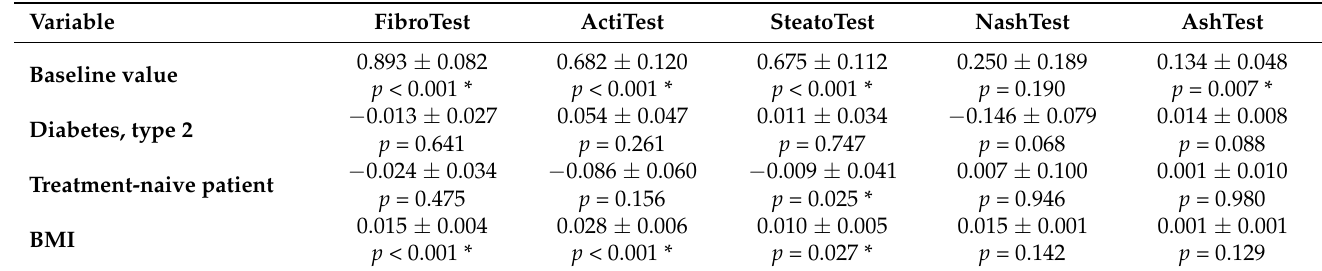
Table 5. Multivariate regression analysis of factors impacting the final fibrosis